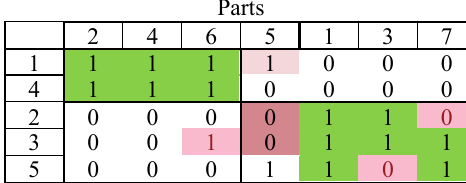
Fig. 6. Second optimal 2-cell solution with minimum exceptions and highest